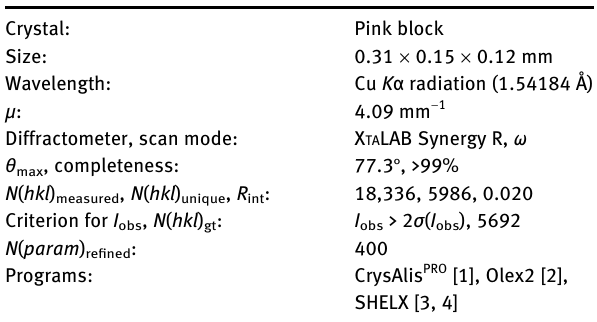
Table  : Data collection and